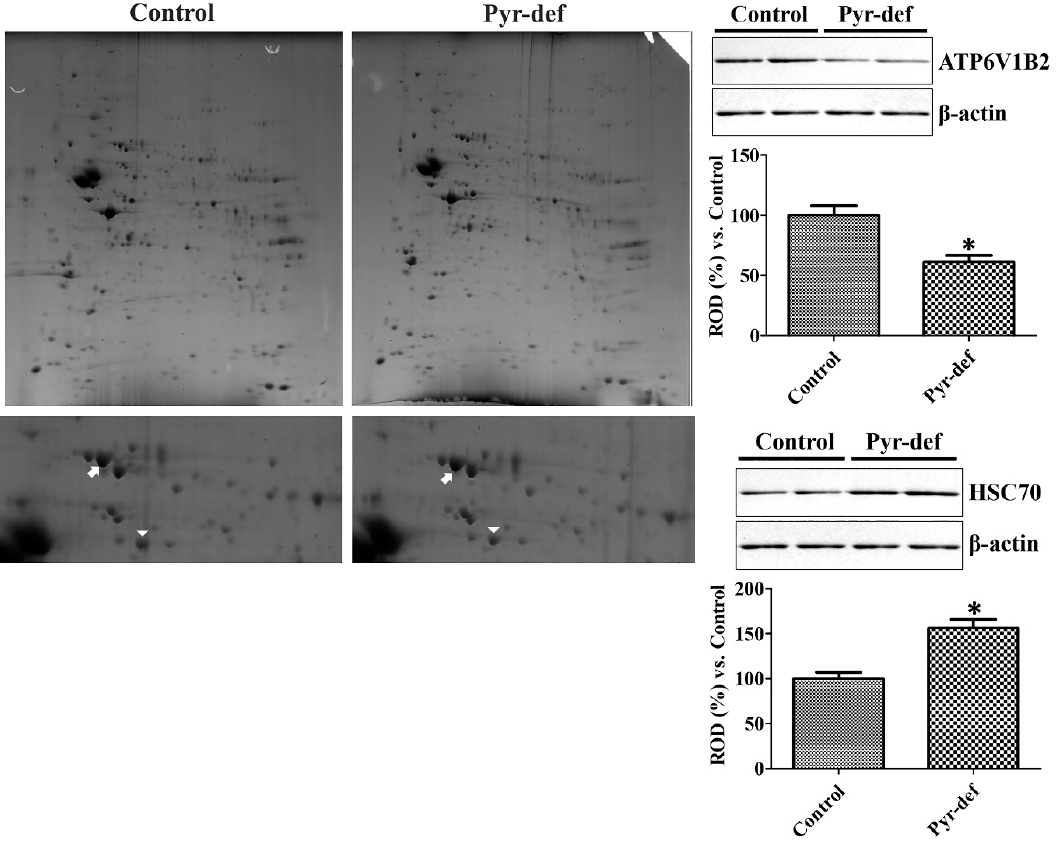
Figure 3. Two-dimensional gel electrophoresis (2DE) and subsequent matrix-assisted laser desorption/ionization time-of-flight mass spectrometry (MALDI-TOF MS) analysis of the hippocampus of control and pyridoxine deficient diet-fed mice. (Left) 2DE gels are enlarged and each panel shows an enlarged view of 2DE gel spots that were expressed differentially (arrowheads and arrows are ATP6V1B2 and HSC70, respectively). (Right) Western blot analysis of differentially expressed proteins (ATP6V1B2 and HSC70) in the hippocampus of control and Pyr-def mice ( n = 6 per group; * P < 0.05, vs. vehicle-treated group). All data are shown as the ratio to control group ± SEM.